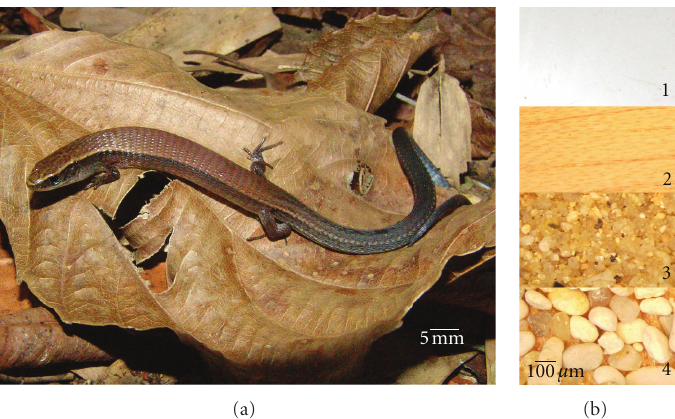
Figure 1: (a) Colobodactylus taunayi on litter; (b) experimental substrates with a gradient of increasing roughness average (RA): 1, plastic (RA = 3); 2, wooden board (RA = 9 . 765); 3, glued sand (RA = 546), and 4, glued gravel (RA =